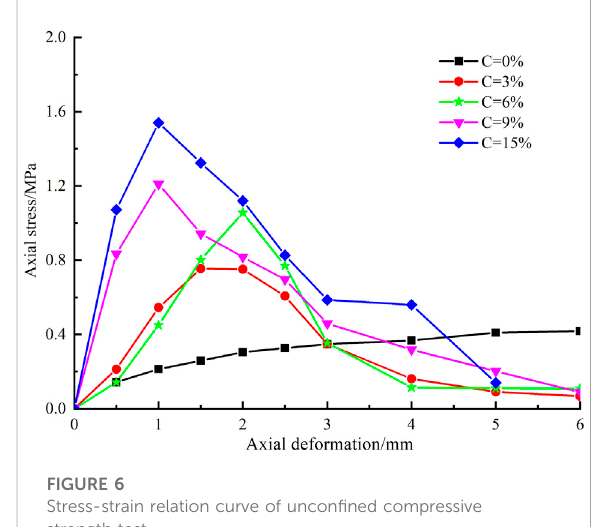
FIGURE 6 Stress-strain relation curve of uncon fi ned compressive strength test.